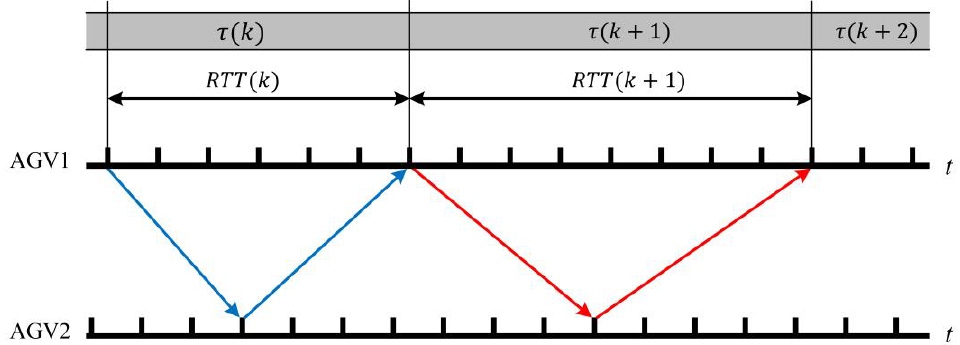
Figure 4. Schematic diagram of Kalman filter delay estimation.